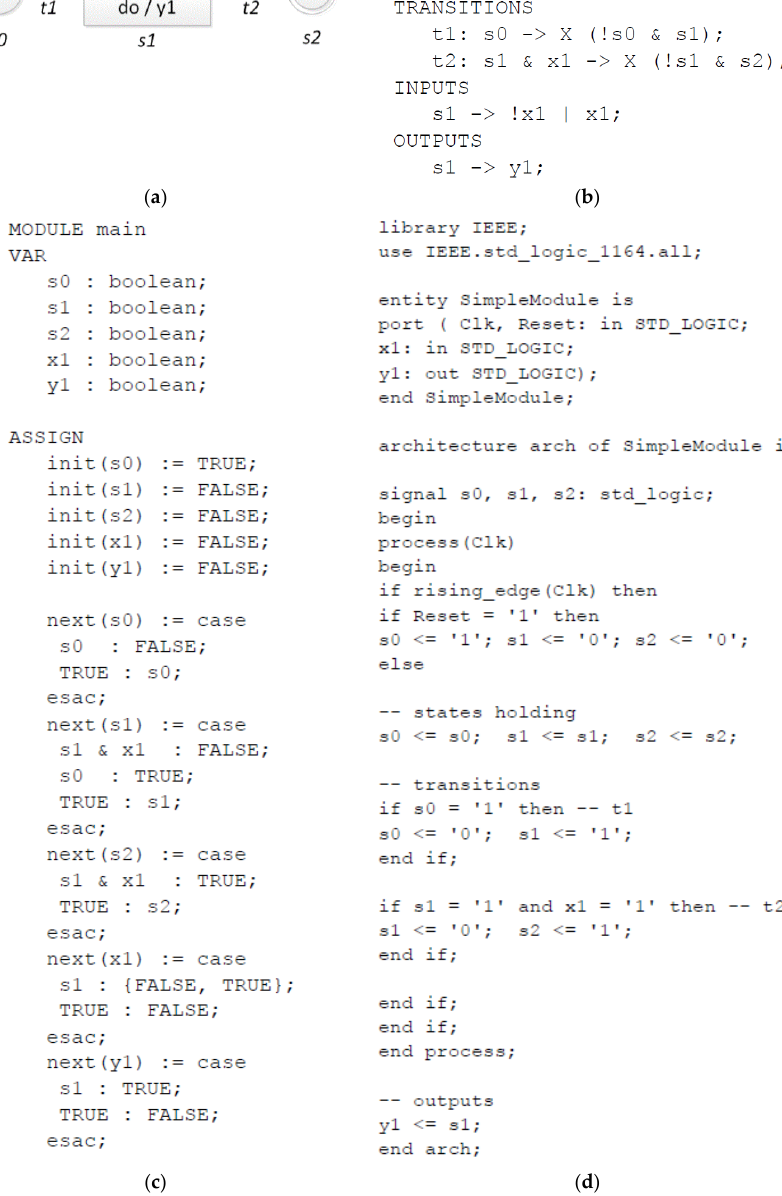
Figure 3. Illustration of the algorithms: a simple state machine diagram ( a ), the corresponding rule-based logical model ( b ), a generated verifiable model in the nuXmv format ( c ) and a generated synthesizable model in VHDL ( d ).